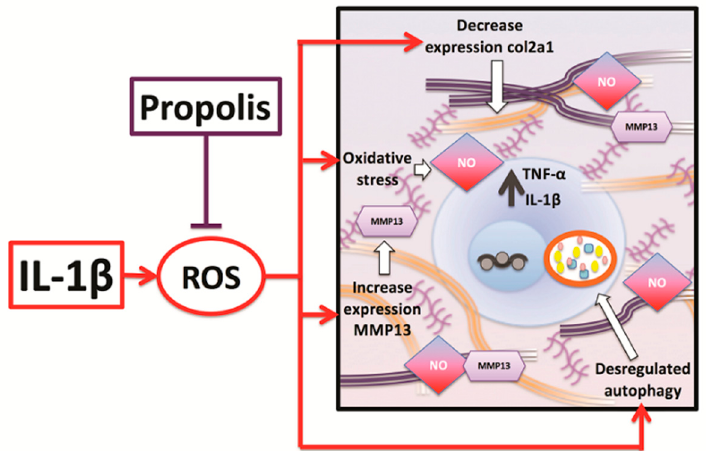
Figure 7. Mechanism proposed by which EEP treatment can reverse the alterations generated by the inflammatory stimulus in chondrocytes. Defects that are generated by the inflammatory stimulation in chondrocytes such as decrease expression of col2a1, increase of nitric oxide production, increase of MMP13 expression and deregulation of autophagy proteins are inhibited by EEP treatment through an antioxidant mechanism.